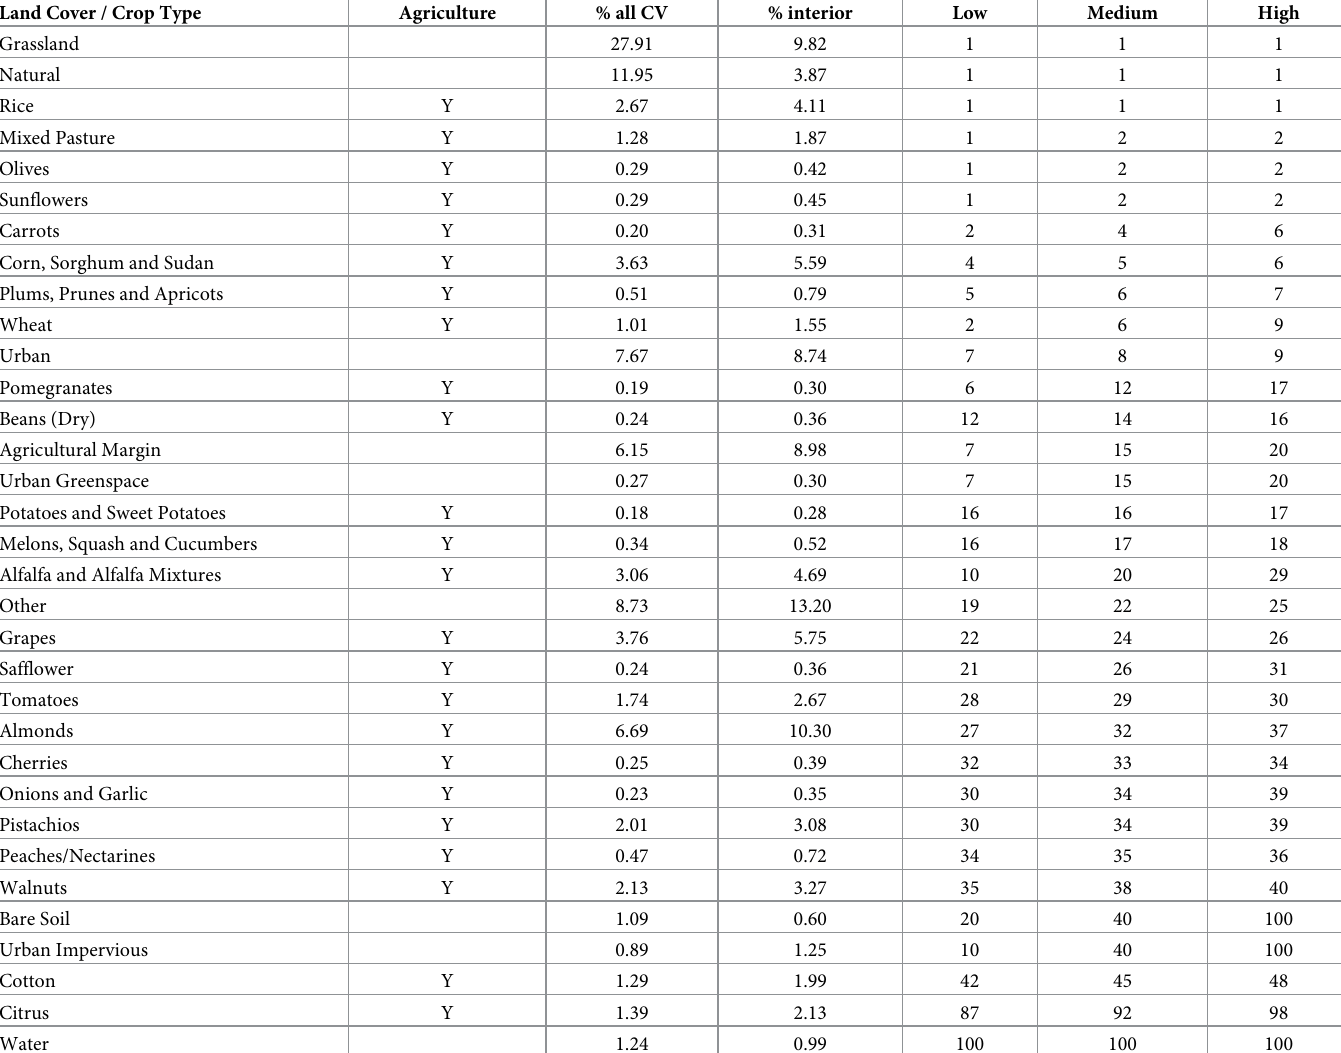
Table 1. Land cover types and resistance values assigned to each land cover / crop type under the low, medium, and high resistance scenarios (the table is sorted by the medium category). Land Cover / Crop Type